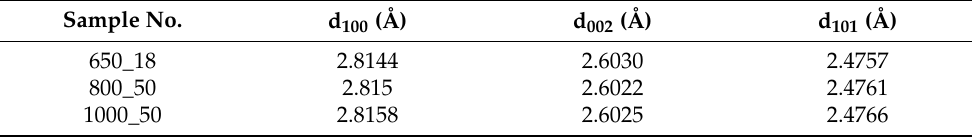
Table 3. The interatomic distances (d) for individual planes of investigated samples. Sample